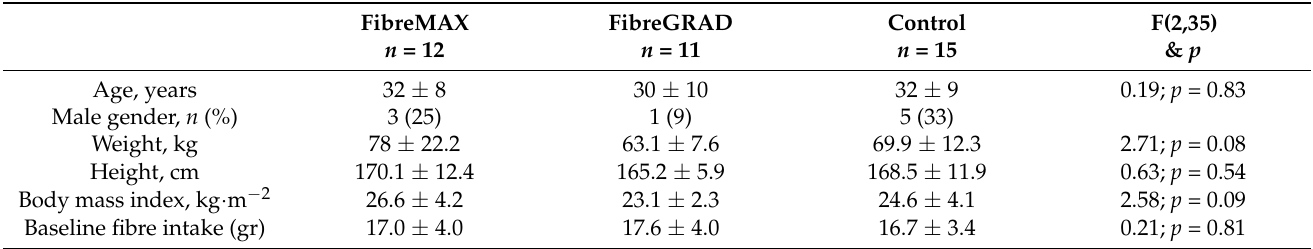
Table 1. Participant characteristics by study condition (values mean ± SD or frequency distribution in percentage) and the results of the one-way ANOVA (F value and p